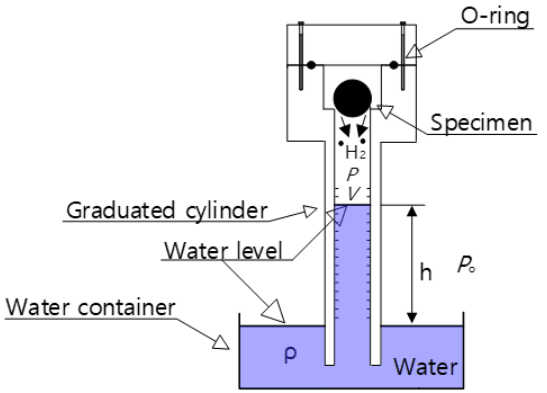
Figure 1. VAT system in which the cylinder is standing upright in distilled water. A VAT system measured the released H 2 . A graduated cylinder, immersed partially in a distilled water container, collected and measured the emitted H 2 gas with an O-ring to prevent a gas leak. The pressure ( P ) in the cylinder for the H 2 measurement, shown in Figure 1, is written as [18]